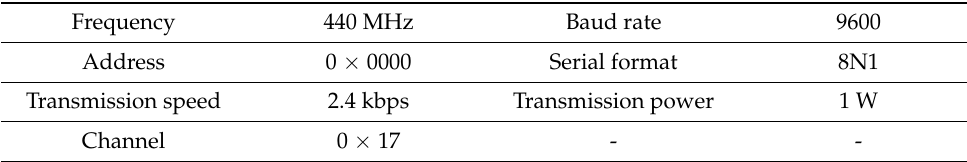
Table 5. Parameters meeting the requirements of the research site.